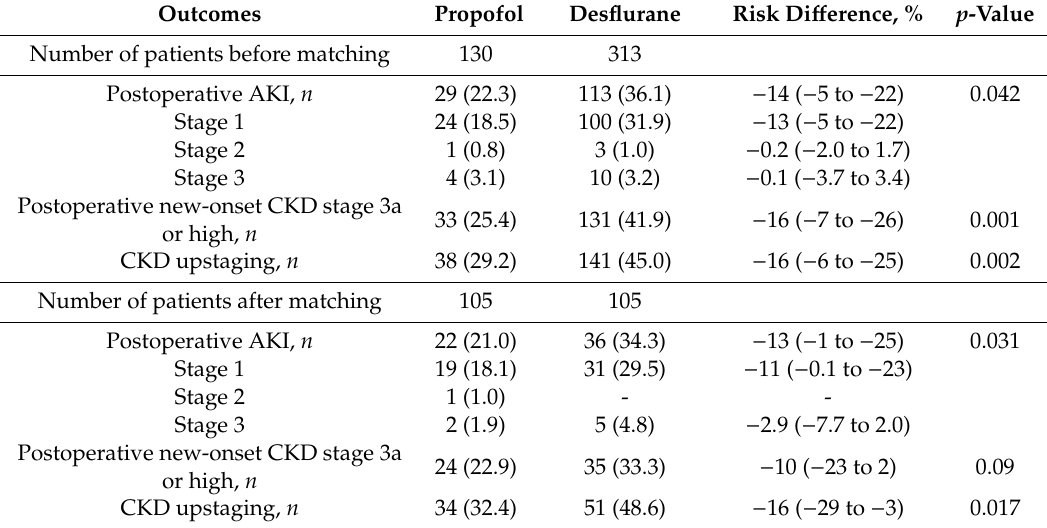
Table 3. Comparison of incidence of primary and secondary outcomes between patients according to the main anesthetic agents during surgery before and after propensity score matching.